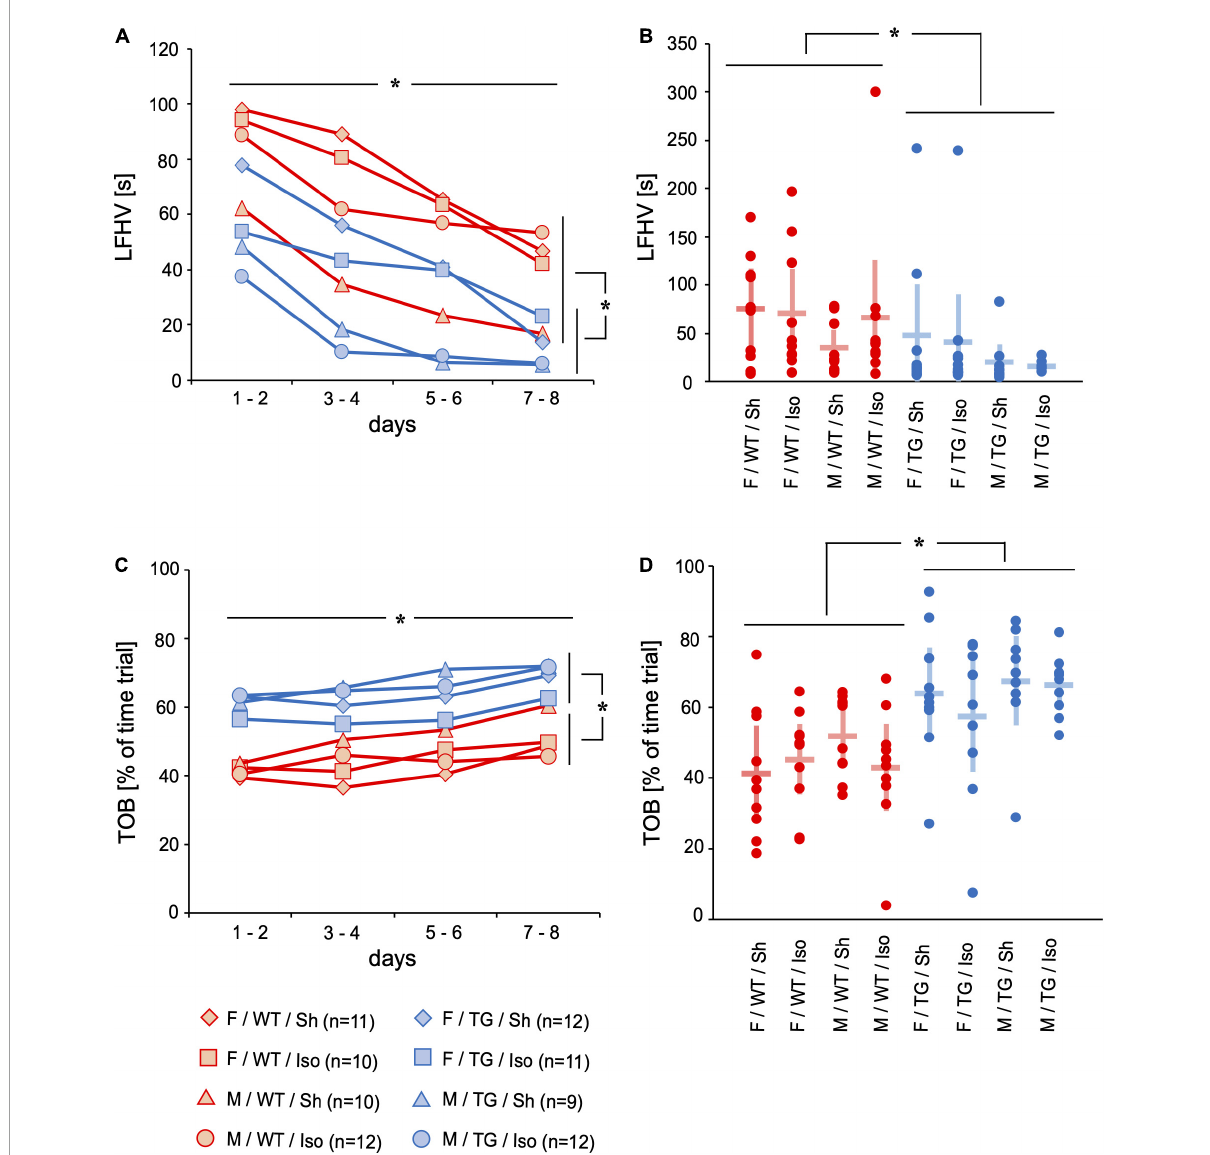
FIGURE1 Latency to the first hole visit (LFHV) [s] and time on board (TOB) [% = fraction of time trial]. Mean of 4 trials per day on 2 days over time (A,C) and mean and 95%-confidence interval of 4 trials per day on all 8 consecutive days (B,D) sorted by group. LFHV decreased over 8 days of testing. LFHV was lower in Tg2576 compared to WT on days 7–8 and over all days. TOB increased over 8 days of testing. TOB was higher in Tg2576 compared to WT on days 7–8 and over all days. F, female; M, male; WT, wildtype (red); TG, Tg2576 (blue); Sh, sham procedure; Iso, isoflurane anesthesia. * p <